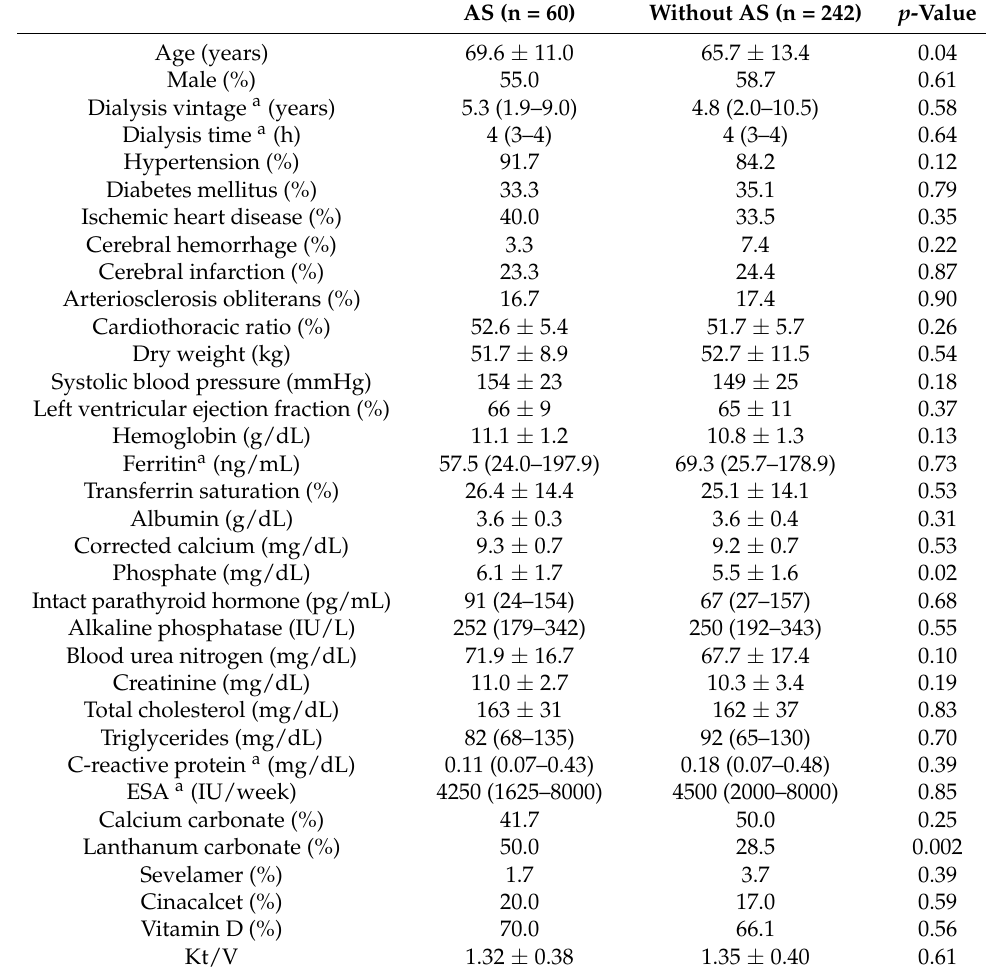
Table 1. Patient characteristics according to the development of aortic sclerosis during the observation